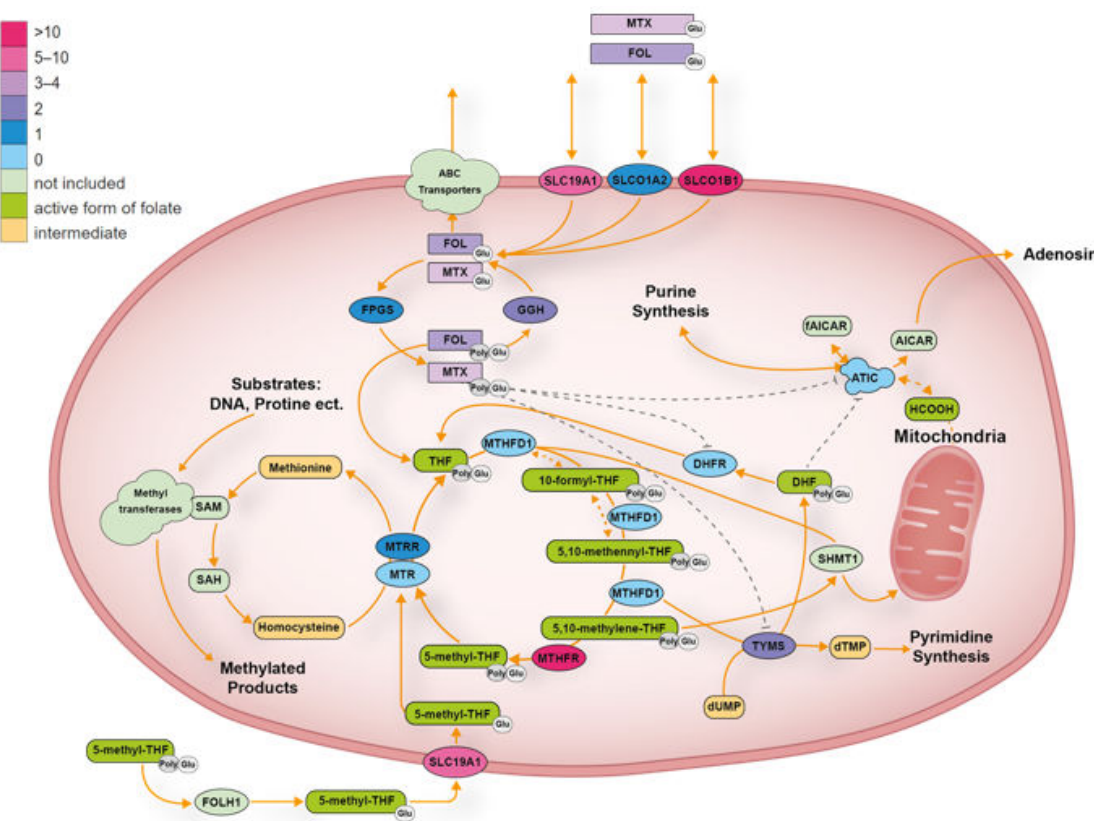
Figure 3. Folate transport pathway. The color scheme for the folate pathway genes reflects the number of studies that found a significant pharmacogenetic association with MTX exposure. AICAR: 5-aminoimidazole-4-carboxamide ribonucleotide; DHF: dihydrofolate; dUMP: deoxyuridine monophosphate; dTMP: deoxythymidine monophosphate; fAICAR: 5-formamidoimidazole-4-carboxamide ribonucleotide; FOL: folate; Glu: glutamated; FOLH1: N-acetyl-L-aspartyl- L-glutamate peptidase; I HCOOH: formic acid; MTX: methotrexate; Poly: prefix, meaning more than one, SAM: S-adenosyl methionine, SAH: S-adenosyl-l-homocysteine; SHMT1: serine hydroxymethyltransferase 1; THF: